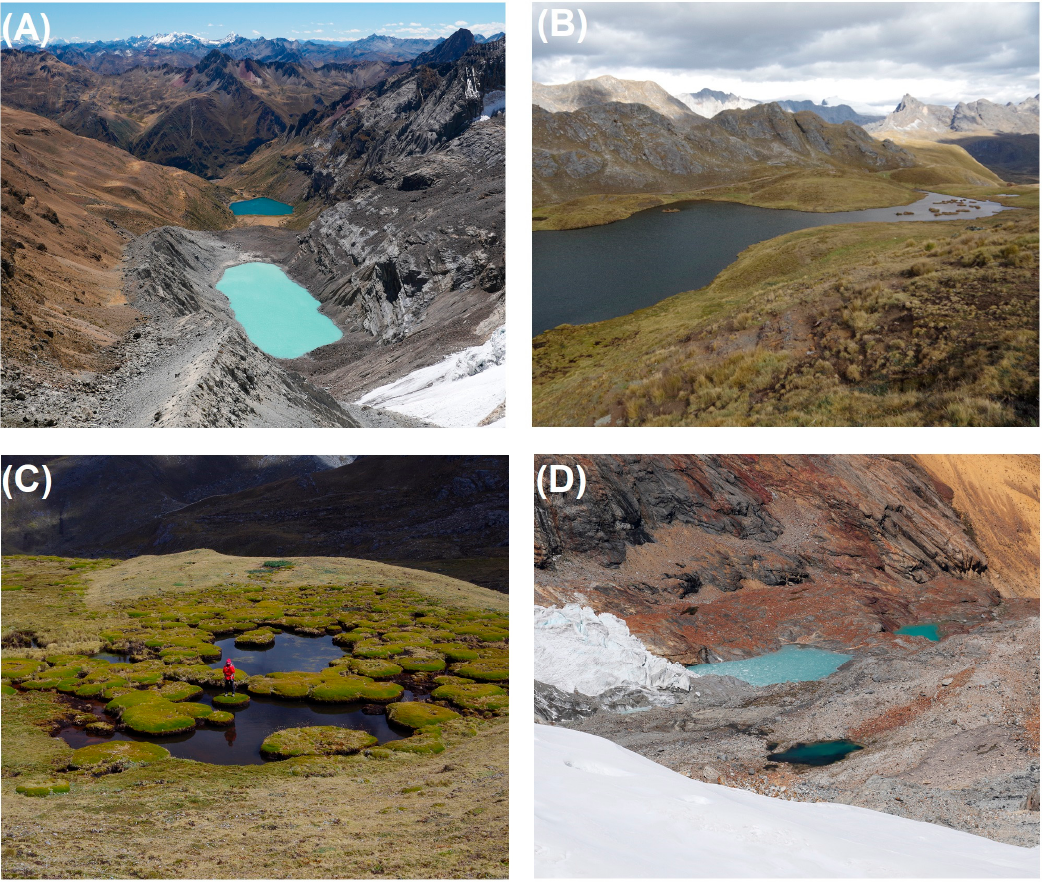
Figure 2. Di ff erent lake types present in the Cordillera Huayhuash. ( A ) Moraine-dammed lakes Barrosacocha (upstream, W006) and Rasaqcocha (downstream, W005); ( B ) large bedrock-dammed Lake Huaracacocha (E012); ( C ) an example of relict (‘pampa’ type) lake near the Siula Punta; and ( D ) a small moraine- (in front) and two bedrock-dammed lakes (one of which is proglacial) near the Rasac Punta. All images were taken in 2018 and 2019 by AE.